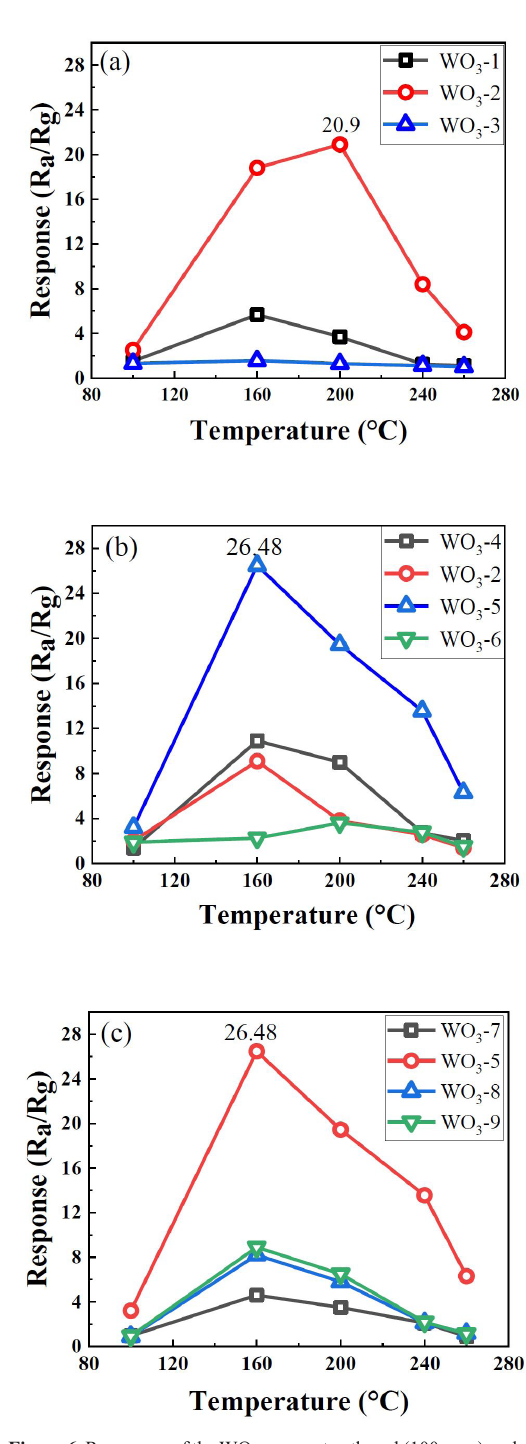
Figure 5. XPS spectrum of WO spectrum, and (c) O1s spectrum.